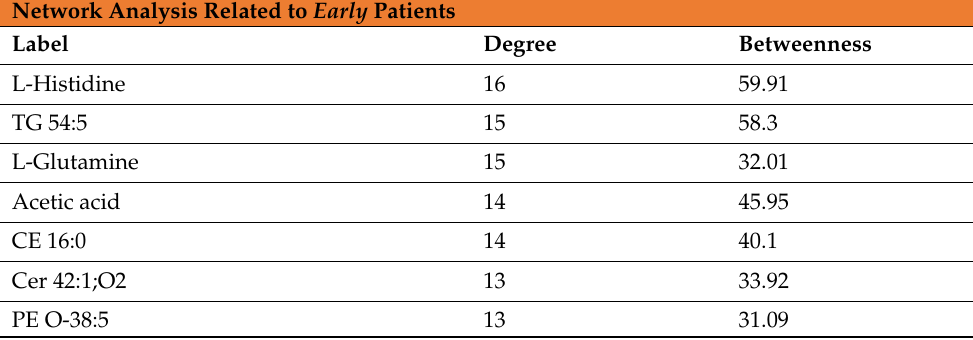
Table 2. DSPC network analysis. Degree of node and betweenness of the interrelationships calcu- lated on the metabolites with VIP > 1 related to the early and advanced ALS patients.